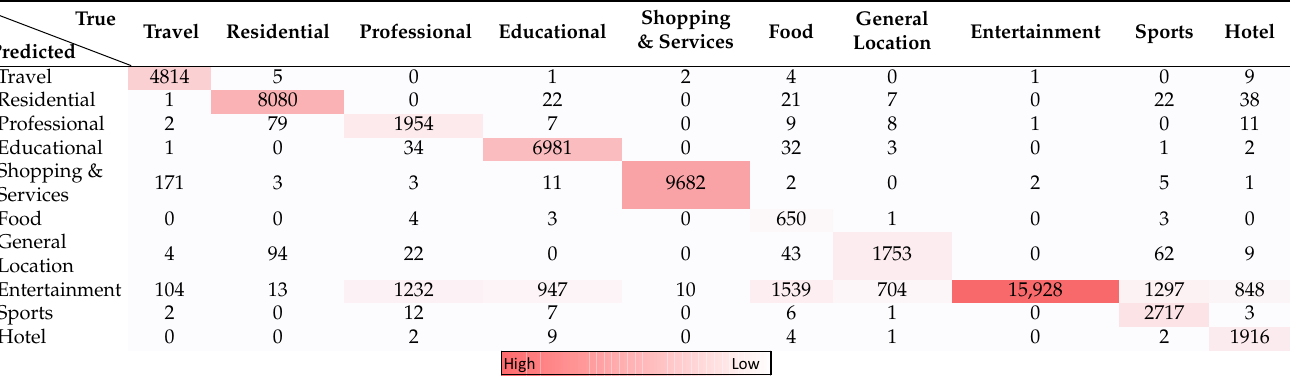
Table 4. Confusion Matrix for Deep-Learning Model. Table 5. Confusion Matrix for Logistic Regression Model. Table 5. Confusion Matrix for Logistic Regression Model.